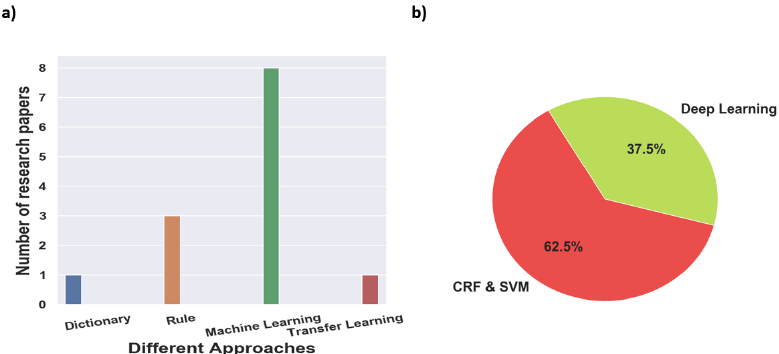
Figure 3. ( a ) Representation of the various clinical NER models based on different approaches for this survey paper and ( b ) percentage of NLP models identified based on different machine learning approaches.